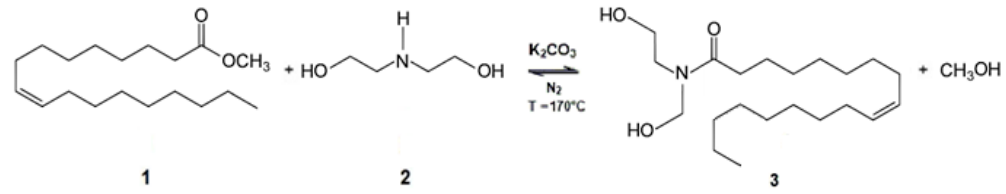
Figure 1. OADA synthesis scheme where the main chemical species involved were highlighted as 1 : Methyl oleate, 2 : diethanolamine and 3 : OADA. Methyl oleate, 2 : diethanolamine and 3 :